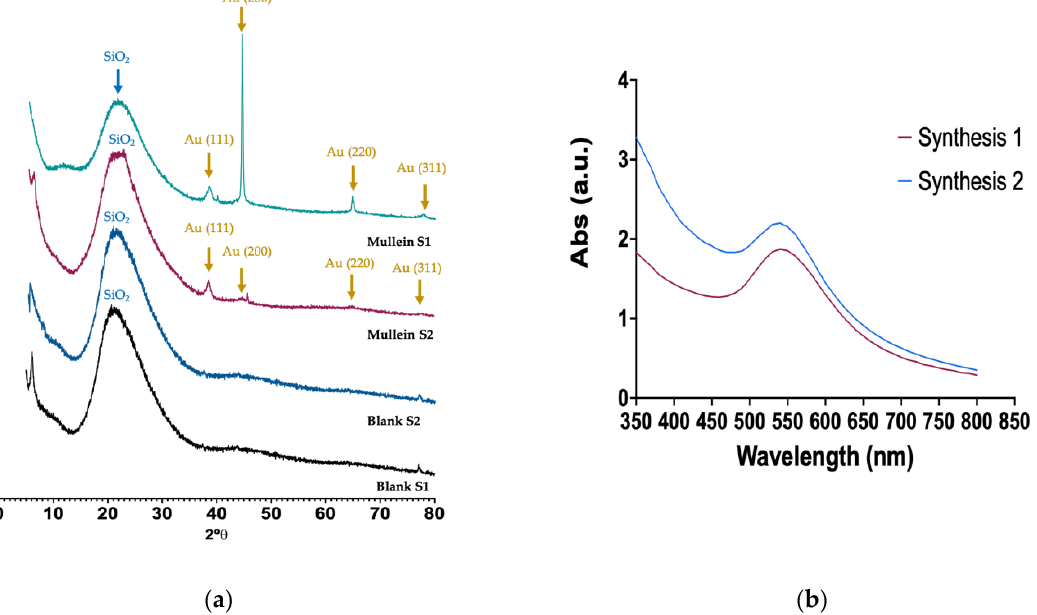
Figure 3. ( a ) X-ray diffraction of silica and silica – gold nanoparticles synthesized with two methods, ( b ) UV-Vis spectra of silica – gold